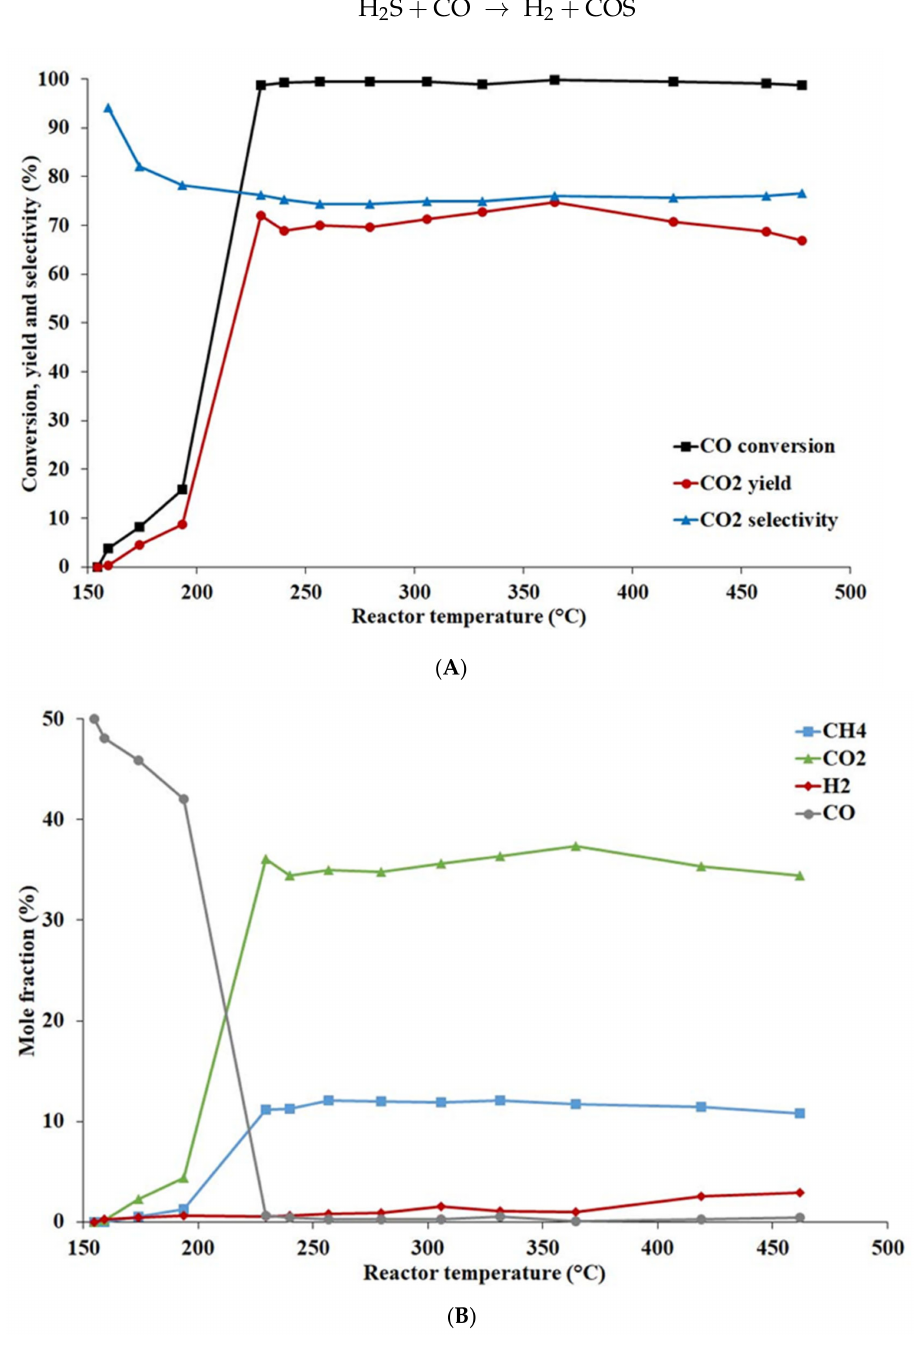
Figure 5. Catalytic tests with feed gas mixture 1 (50 mole% CO and 50 mole% N 2 ) at pressure 6 MPa over a commercial Ni-based catalyst: ( A )—CO conversion, CO 2 yield, and CO 2 selectivity; ( B )—composition of the gas